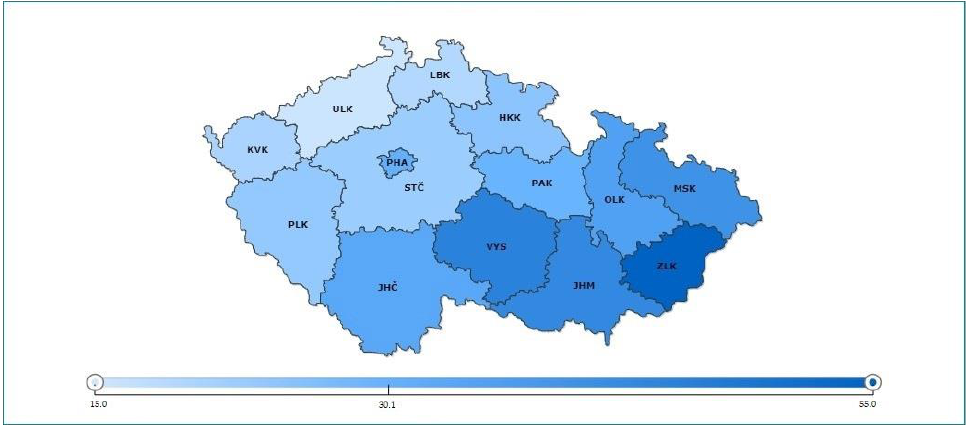
Figure 1. Share of believers in %.